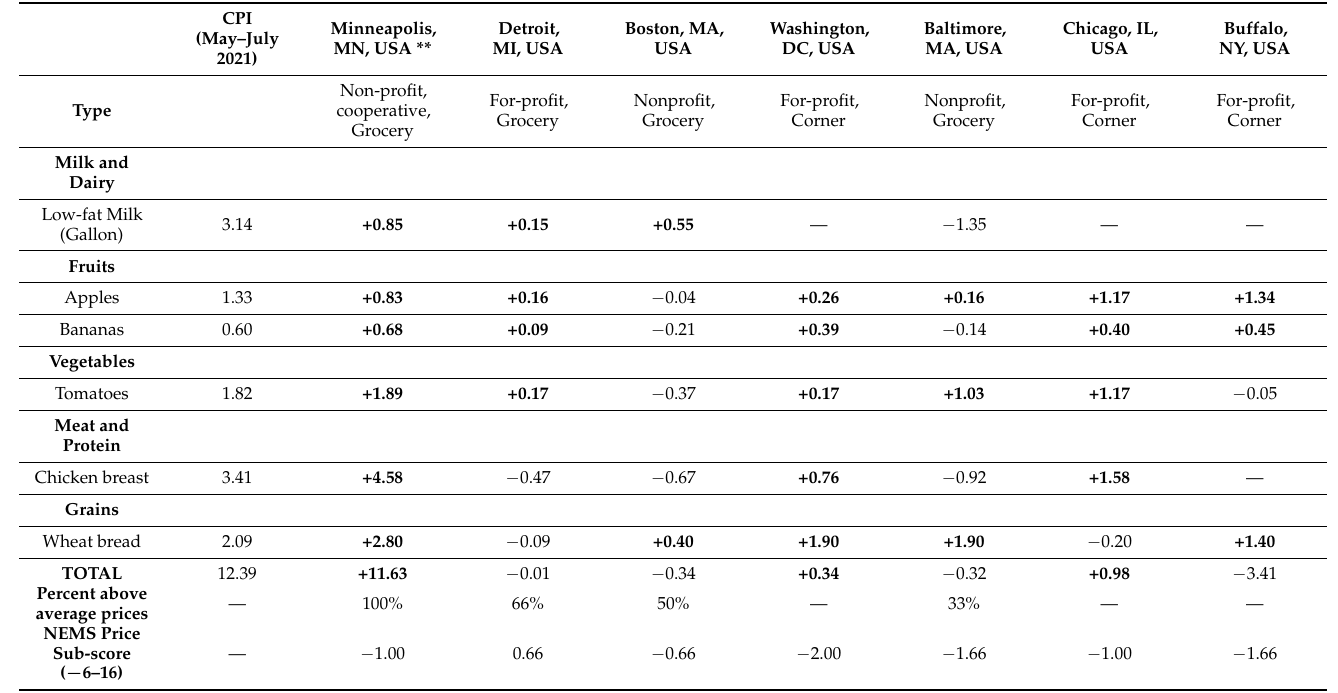
Table 4. Consumer price index averages compared to individual store location price averages for select food